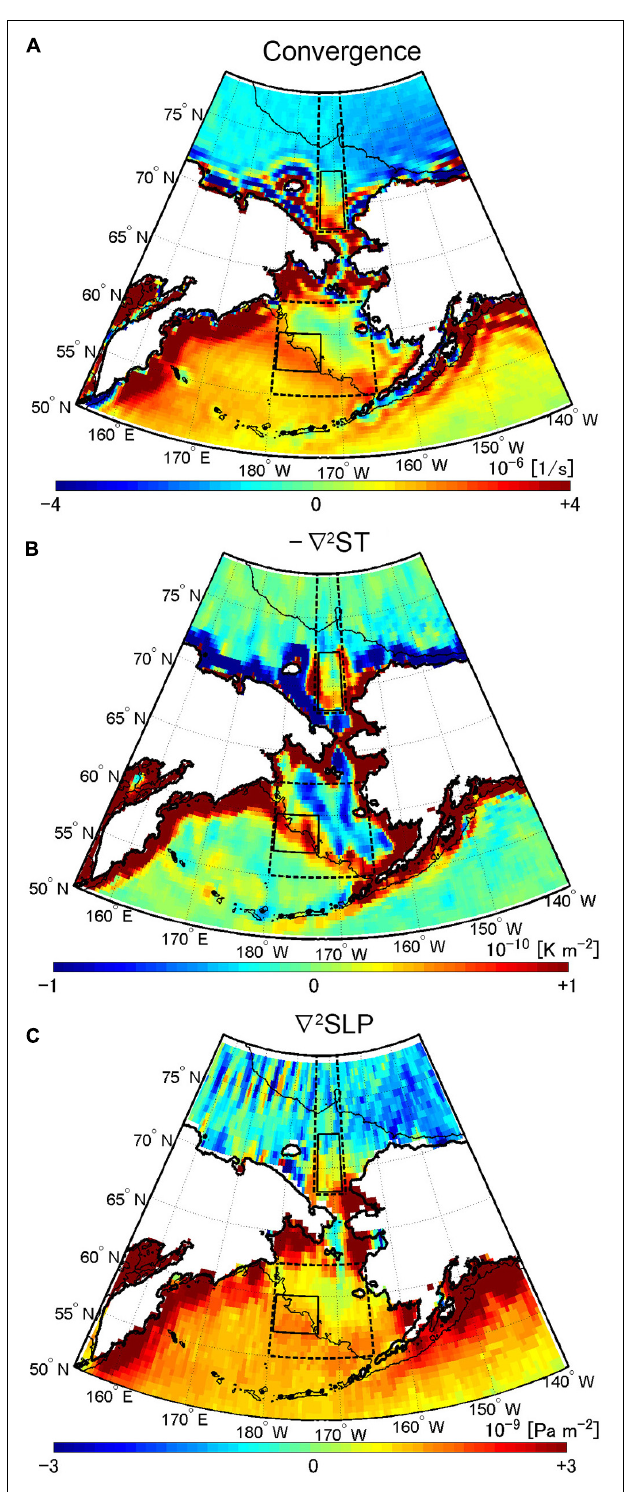
FIGURE 2 | Annual-mean climatologies of (A) 10-m-high wind convergence, (B) the sign-reversed Laplacian of ST, and (C) the Laplacian of SLP. Black solid lines are depth contours of 200 m. Black dashed and solid boxes denote analysis areas in Figures 3 , 4 , respectively. A two-dimensional median filter of 5 × 5 is applied to the Laplacians of ST and